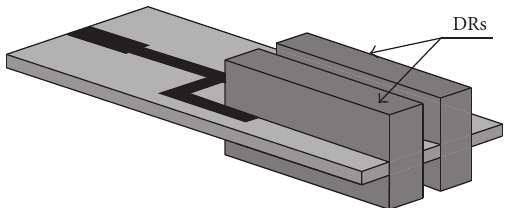
Figure 52: Tridimensional view of a compact UWB DRA with dual- band-rejection characteristics for WiMAX/WLAN bands